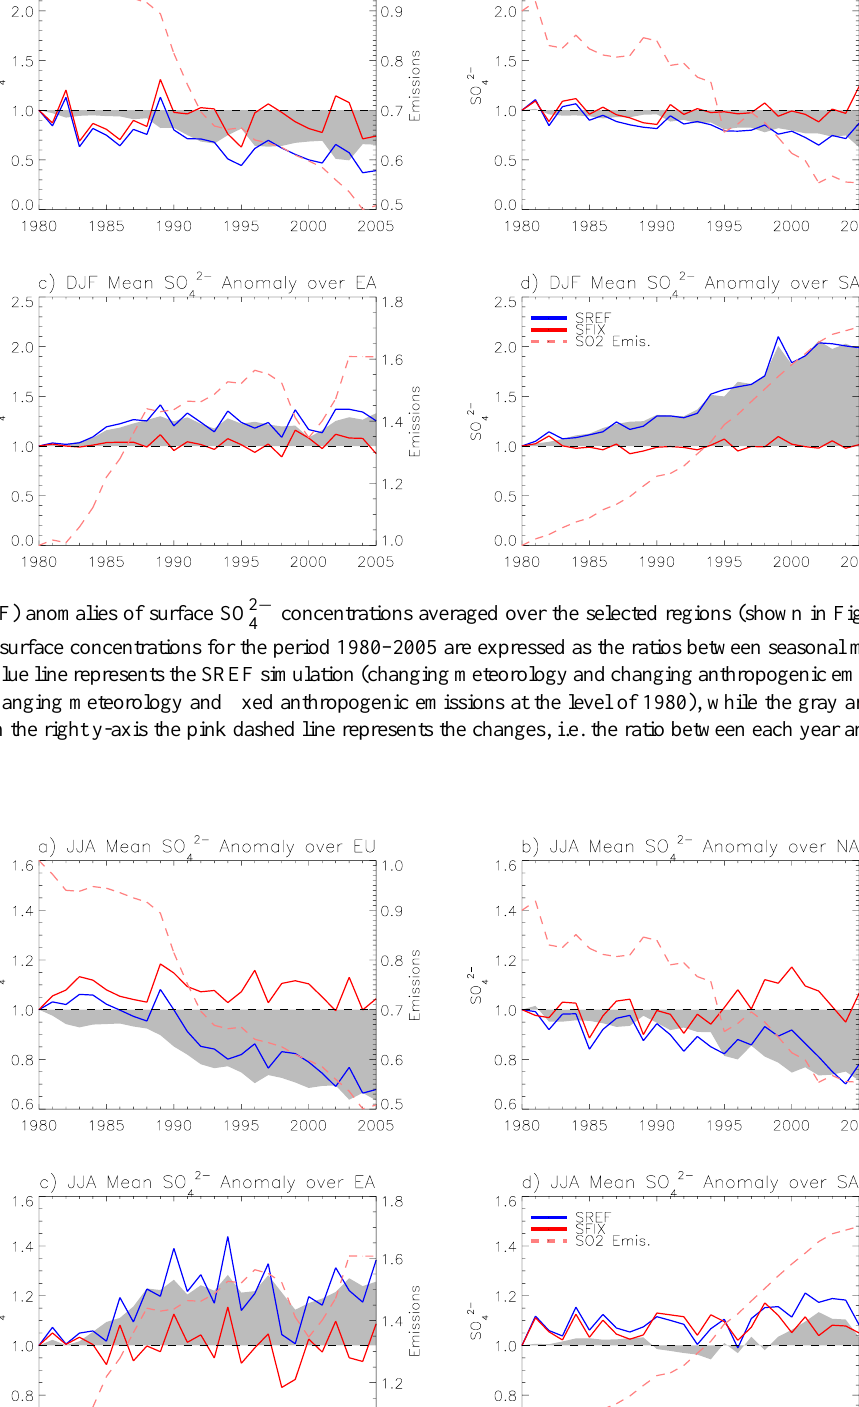
concentrations. 4